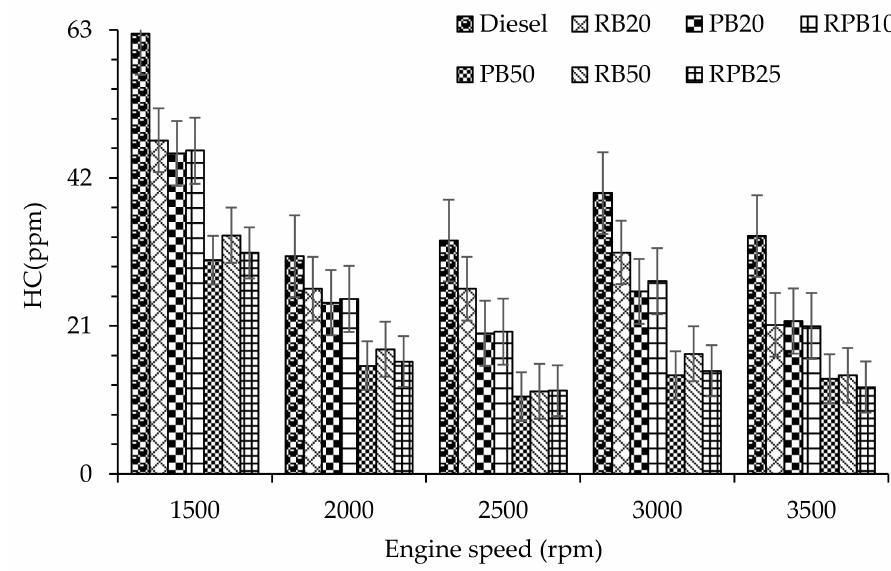
Figure 7. Variation of Hydrocarbon (HC) emission with respect to engine